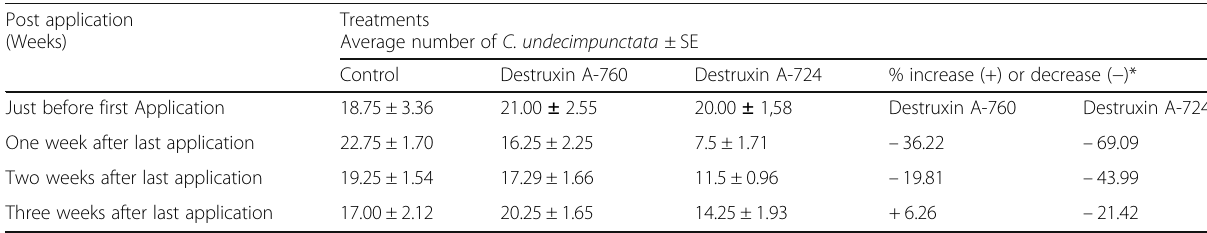
Table 4 The effect of destruxins on C . undecimpunctata (all stages)/50 tomato shrubs after successive post toxin application in